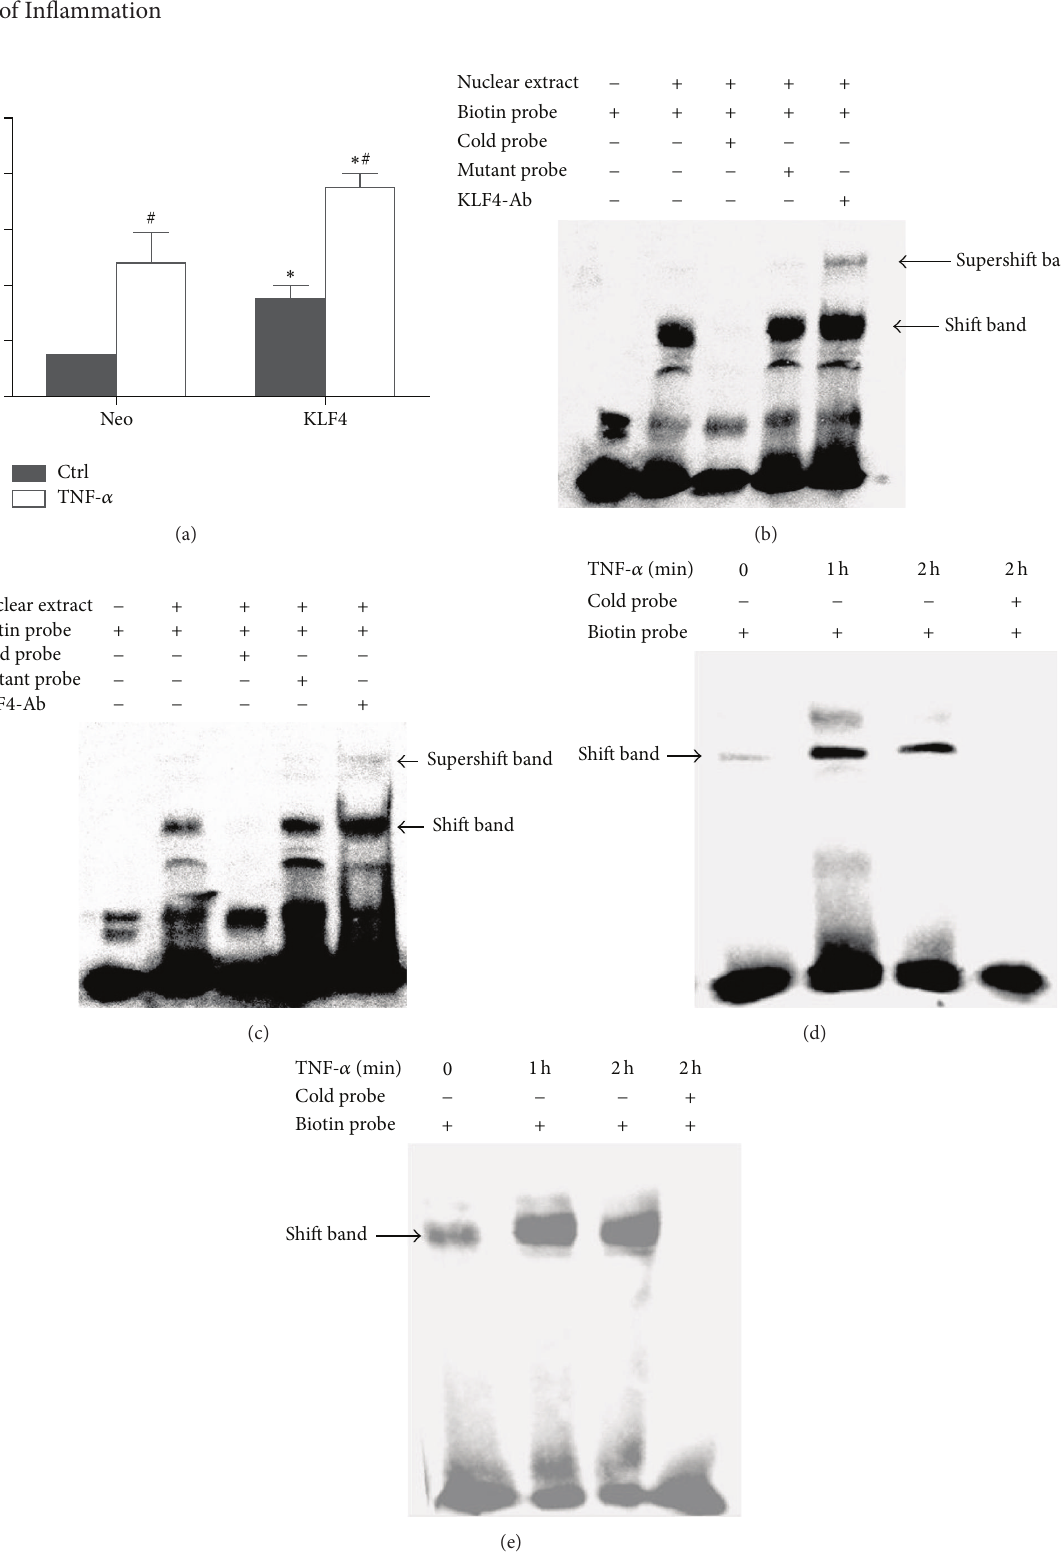
Figure 5: KLF4 regulates IL-6 promoter activity in RA FLSs. KLF4 transactivates the IL-6 promoter. RA FLSs were cotransfected in triplicate with the indicated IL-6 promoter luciferase plasmids, pcDNA3.1-KLF4 expression plasmid (KLF4), or pcDNA3.1 control vector (Neo) for 48 h and then incubated with TNF- 𝛼 (20ng/mL) for 12h. Transcriptional activity was detected by the Dual Luciferase Assay (a). Data were expressed as means ± SEM ( 𝑛 = 3 ). ∗ 𝑃 < 0.05 in comparison to the vector control group (Neo). # 𝑃 < 0.05 in comparison to untreated group (Ctrl). KLF4 binds the IL-6 promoter. EMSA was performed with nuclear extracts using a biotinylated probe of the − 109 to − 90 bp site (b) and − 132 to − 102bp site (below) in the IL-6 promoter (c). TNF- 𝛼 augmented binding of KLF4 to the IL-6 promoter. EMSA was performed with nuclear extracts from cells incubated with TNF- 𝛼 for 1 or 2 h. The previously described biotinylated probes ( − 109 to − 90 bp and − 132 to − 102bp) were used ((d) and (e),